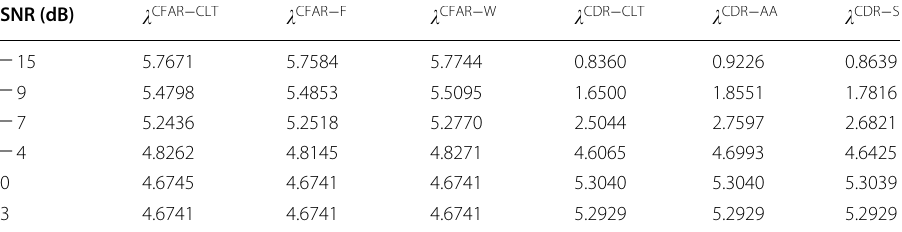
Table 1 Comparison table of the simulation results for